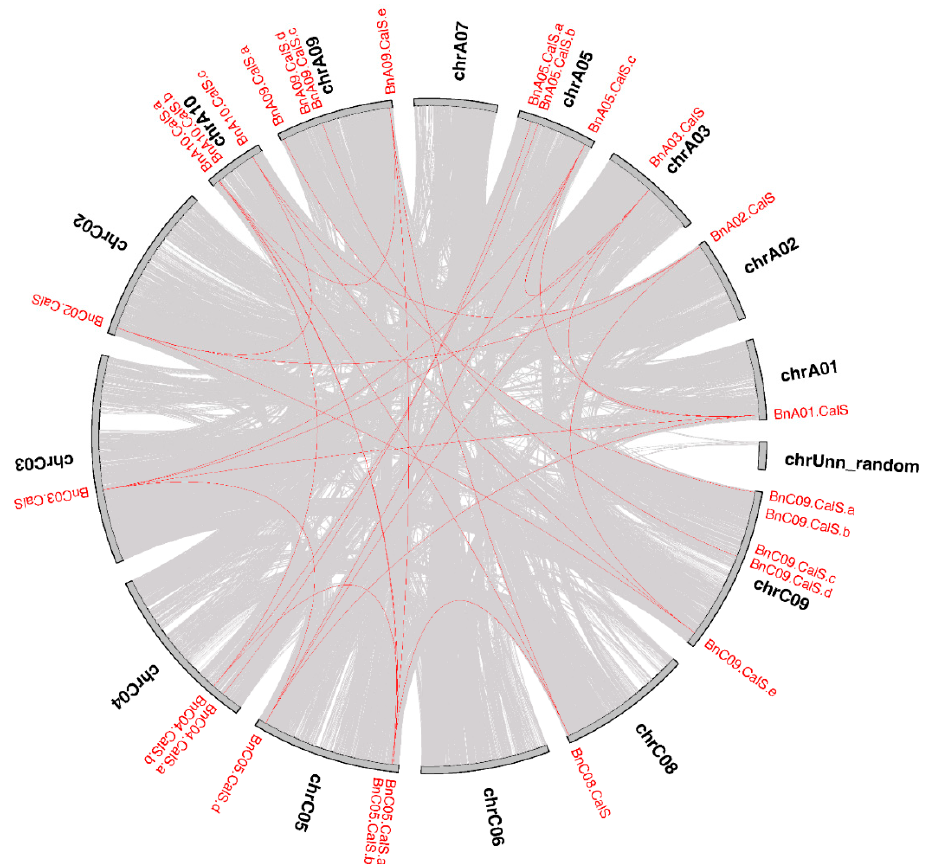
Figure 4. Circle plot showing collinear gene pairs on 12 Brassica napus chromosomes. Grey lines represent collinear blocks in the whole B. napus genome, while red lines indicate collinear BnCalS gene pairs.